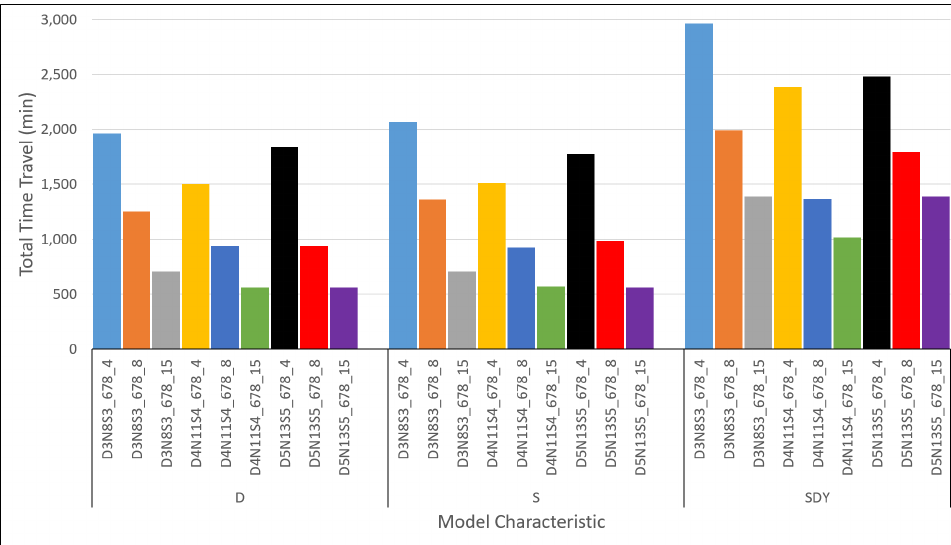
Figure A16. Total Travel Time for Maximum Road Capacity Setting ( 6,7,8 ) in Online and Offline Computation for all Instances grouped by Model